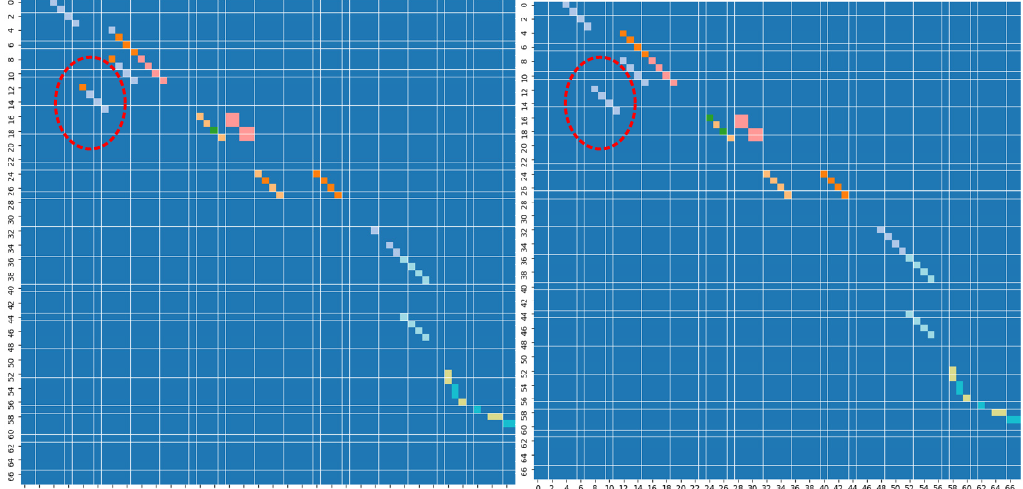
Figure 12. Comparison of associated fault graph.